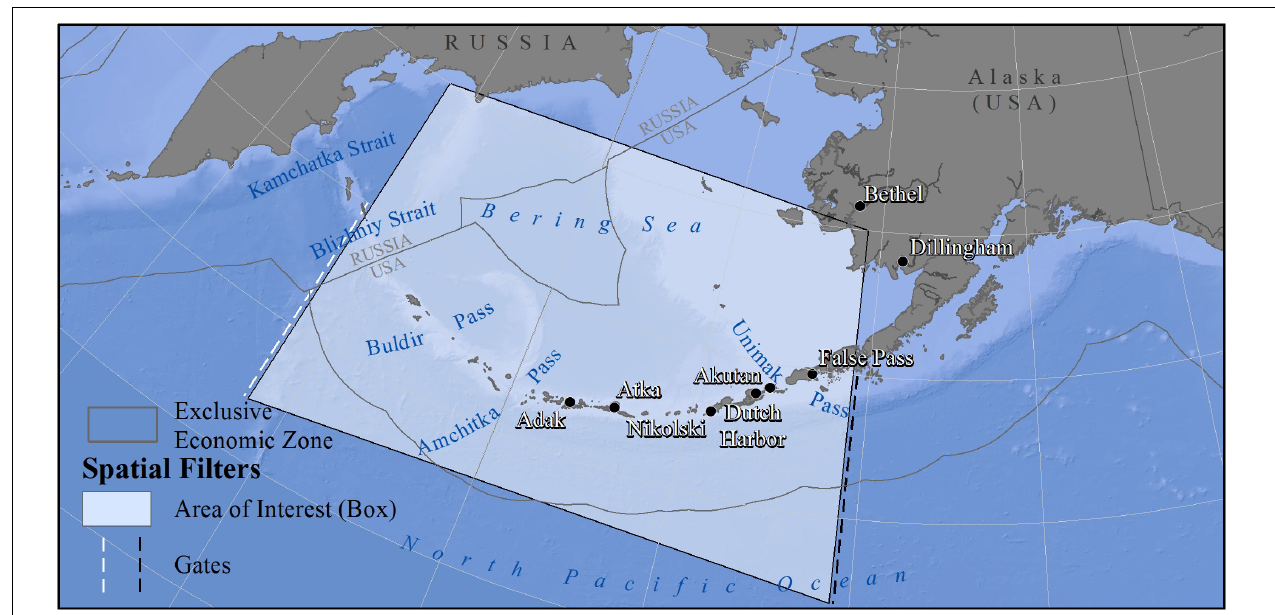
FIGURE 3 | Spatial methods for selecting vessels transiting the North Pacific Great Circle Route. All voyages outside the gray box were excluded from analysis. Gates were drawn along 168 ◦ E (western gate; white hashed line) and 161 ◦ W (eastern gate; black hashed line) to represent the termini of the Aleutian portion of the North Pacific Great Circle Route. All voyages that did not pass through both gates were